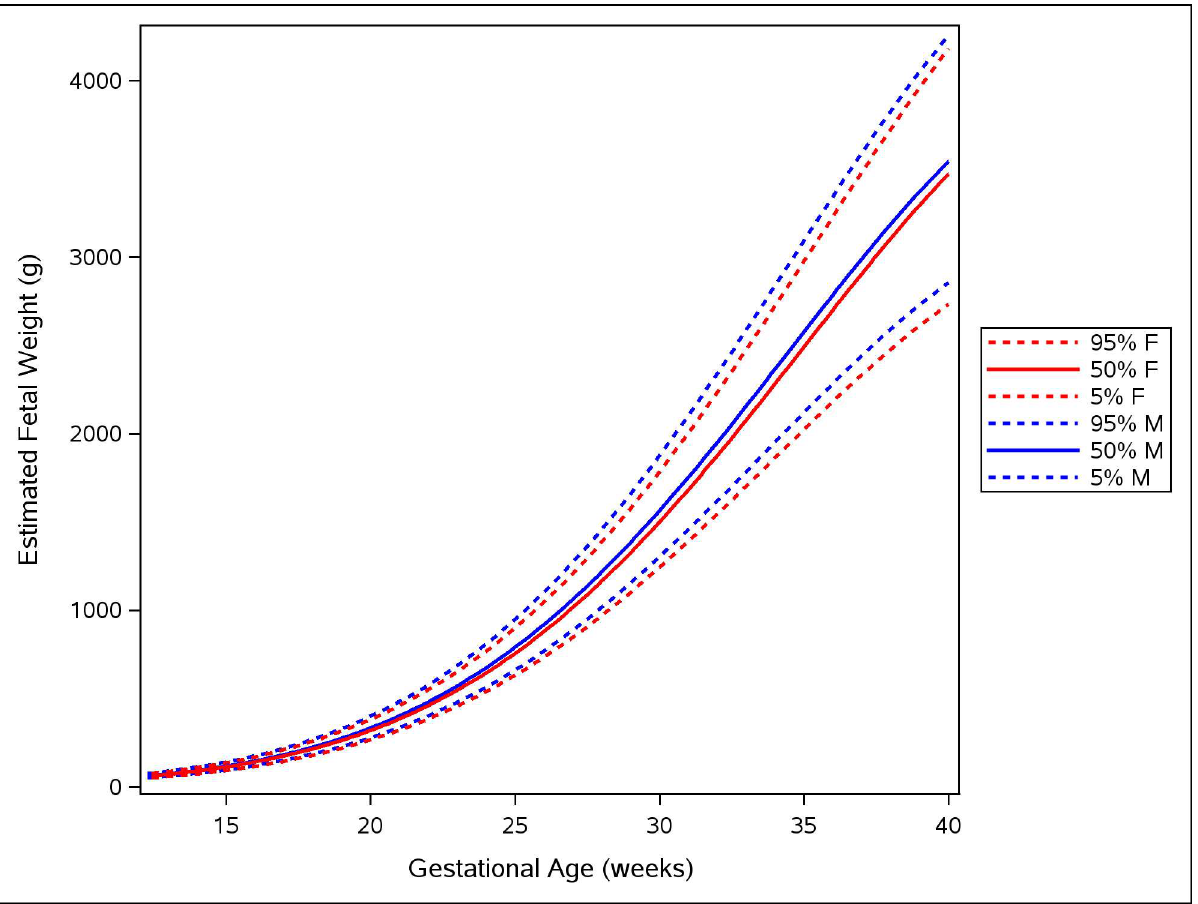
Fig 2. Female and male growth of estimated fetal weight during gestational weeks 14–40. The difference in growth for female (F; red) and male (M; blue) fetuses is shown by the 5th, 50th, and 95th percentilesfor EFW growth. The smoothedlines are basedon quantile regressionthat includesdata from all the participating